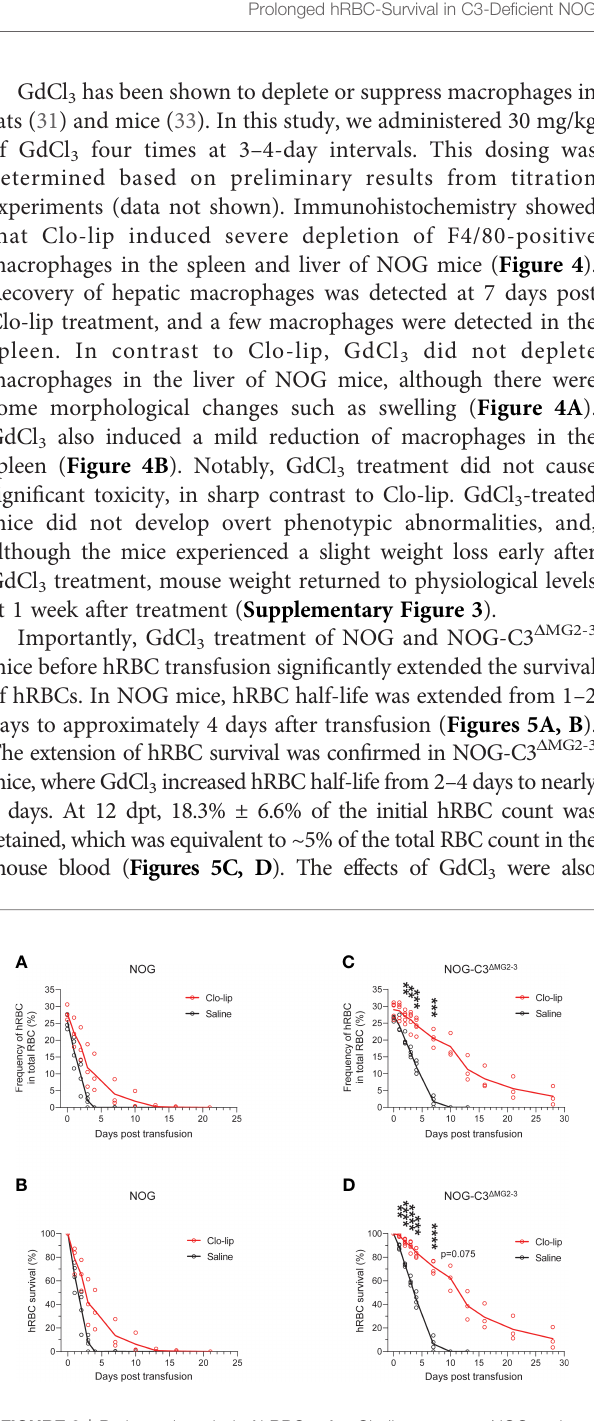
FIGURE 3 | Prolonged survival of hRBCs after Clo-lip treatment. NOG and NOG-C3 D MG2-3 mice were treated with Clo-lip four times at 3 – 4-day intervals. Mice were transfused with hRBCs at 1 day after the last Clo-lip treatment. Frequencies (A, C) and survival rates (B, D) of transfused hRBCs in NOG mice (A, B) and NOG-C3 D MG2-3 mice (C, D) . The NOG group consisted of four saline-treated and four Clo-lip-treated mice. The NOG-C3 D MG2-3 group consisted of four saline-treated and fi ve Clo-lip-treated mice. Two Clo-lip- injected NOG mice (on days 0 and 28) and two Clo-lip-injected NOG-C3 D MG2-3 mice (on days 7 and 10) died during the experiment. Asterisks indicate statistically signi fi cant differences between Clo-lip-injected mice and saline- injected mice as determined using Mixed-effects analysis (****p < 0.0001, ***p < 0.001, and **p < 0.01).